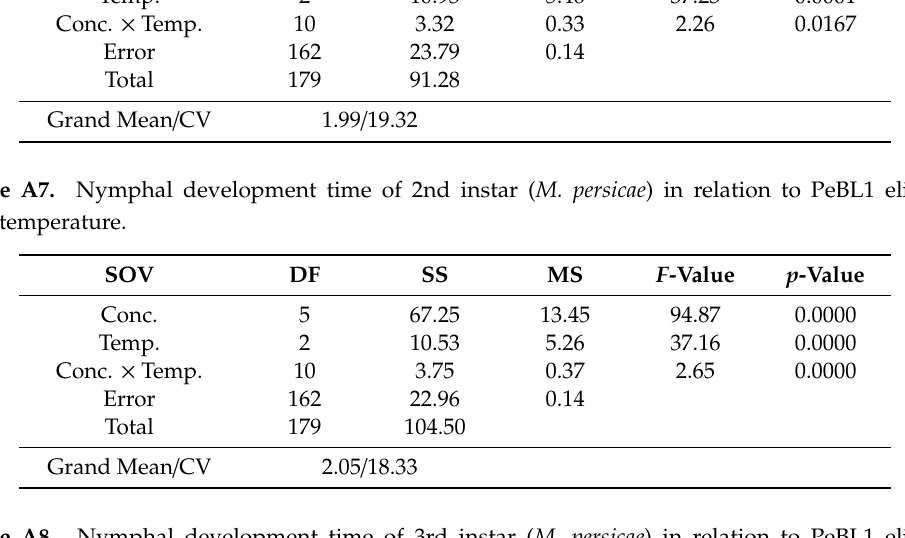
Table A6. Nymphal development time of 1st instar ( M. persicae ) in relation to PeBL1 elicitor and temperature. SOV DF Conc. Temp. Conc. × Temp.